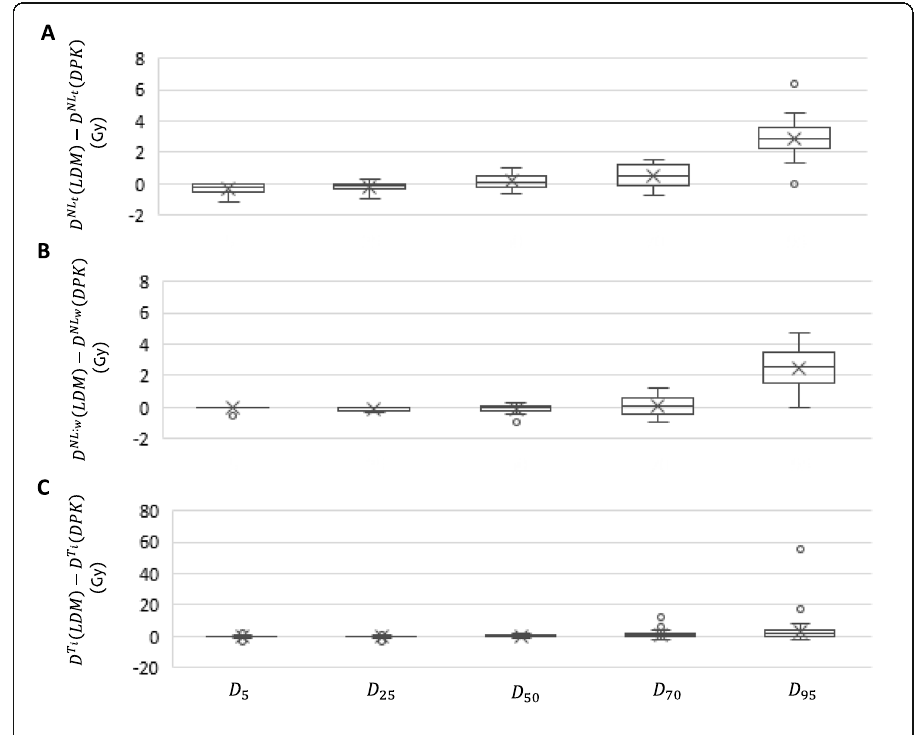
Fig. 5 Boxplot representing absorbed dose differences in Gy between LDM and DPK methods in terms of D 5 , D 25 , D 50 , D 70 , and D 95 delivered to the target normal liver a , whole normal liver b , and individual tumors